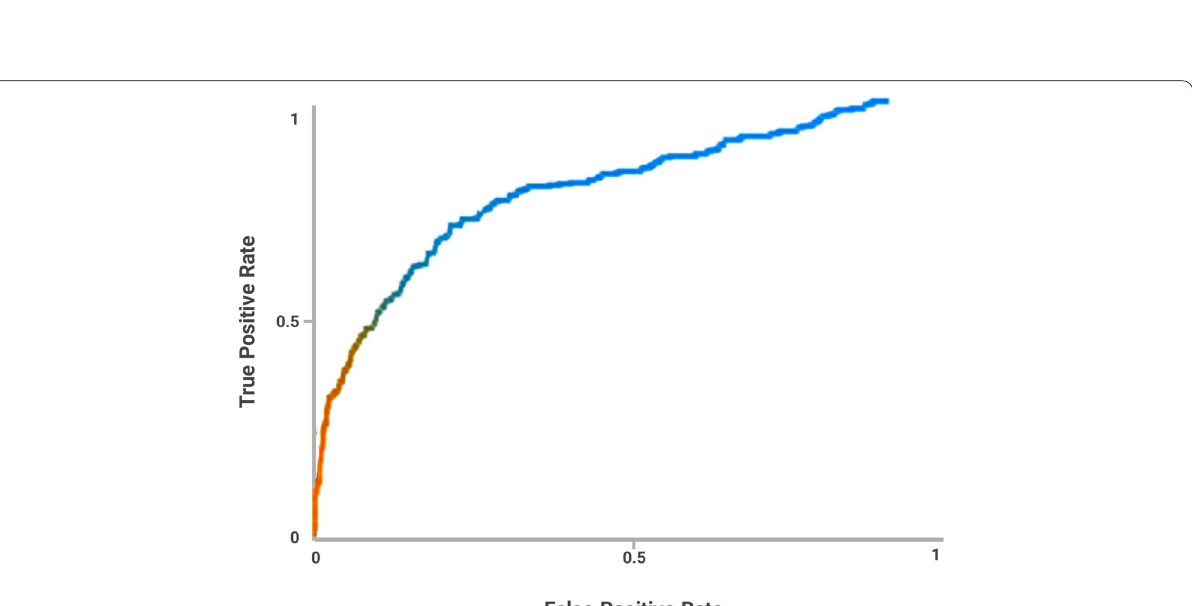
Fig. 8 ROC curve of Netty